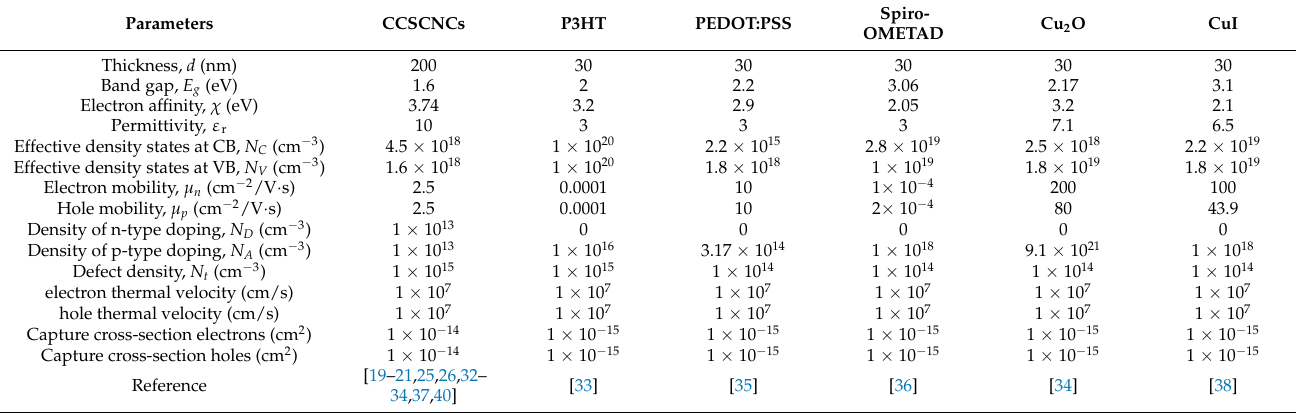
Table 1. Input parameters for CCSCNCs absorber layer and HTL of the PSC